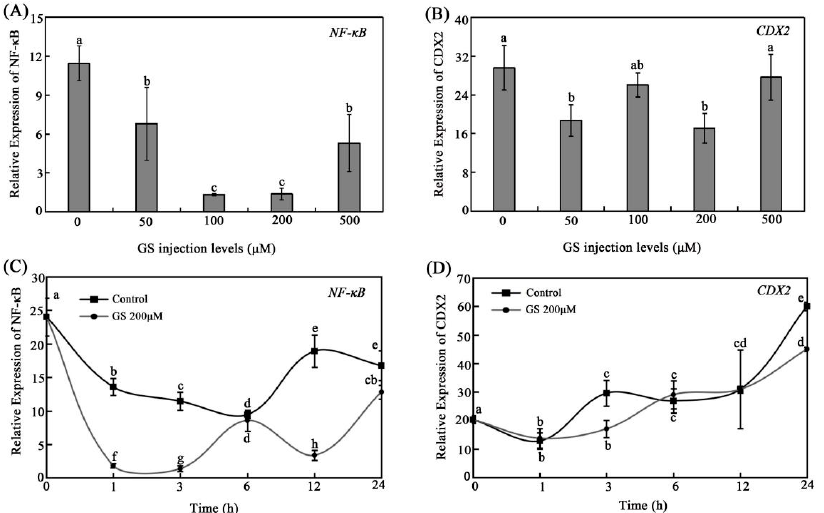
Figure 3. The effect of GS on the expression of NF- κ B and CDX2 in intestines of grass carp. ( A , B ) The relative mRNA expression level of NF- κ B ( A ) and CDX2 ( B ) of grass carp intestine with injection of different levels of GS. ( C , D ) The relative mRNA expression of NF- κ B ( C ) and CDX2 ( D ) with 200 µ M GS injection for different times. The data represent the mean ± SD. Tukey’s multiple range test was performed, and different letters represent significant differences ( p < 0.05, n = 3 for each treatment with a total of nine fish).